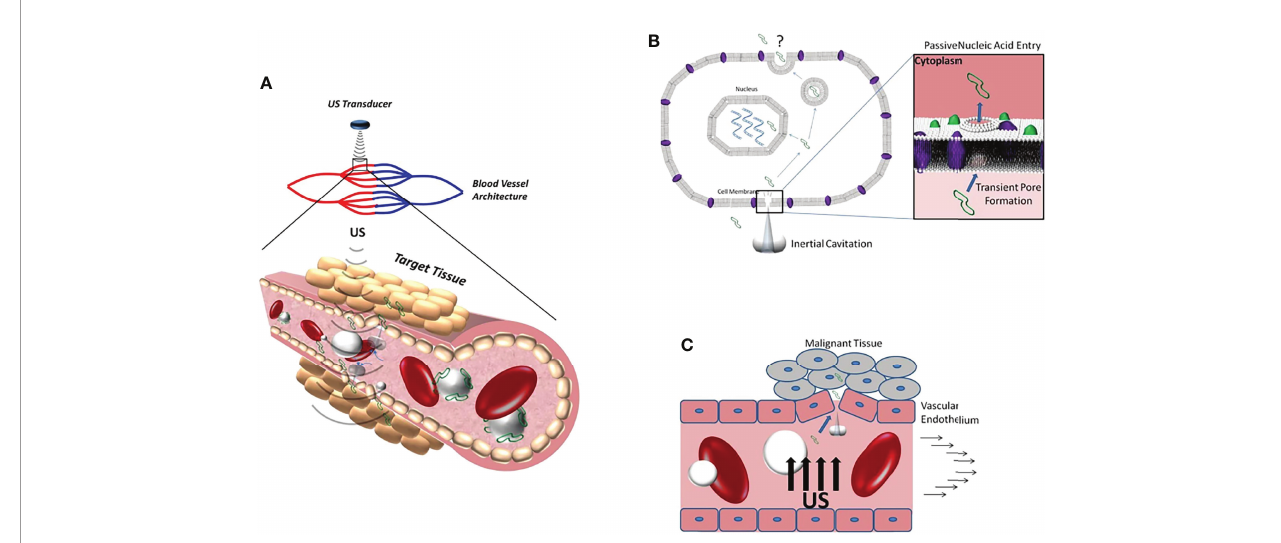
FIGURE 1 | (A) Schematic diagram of ultrasonic cavitation promoting DNA (green) extravasation into tissue. (B) Microjets generated by inertial cavitation creates acoustic pores that allow DNA to enter the cytoplasm. (C) Inertial cavitation increases the permeability of blood vessels to DNA by damaging the integrity of the vascular endothelium. Reprinted with permission from ref (13). copyright © 2012 Sirsi and